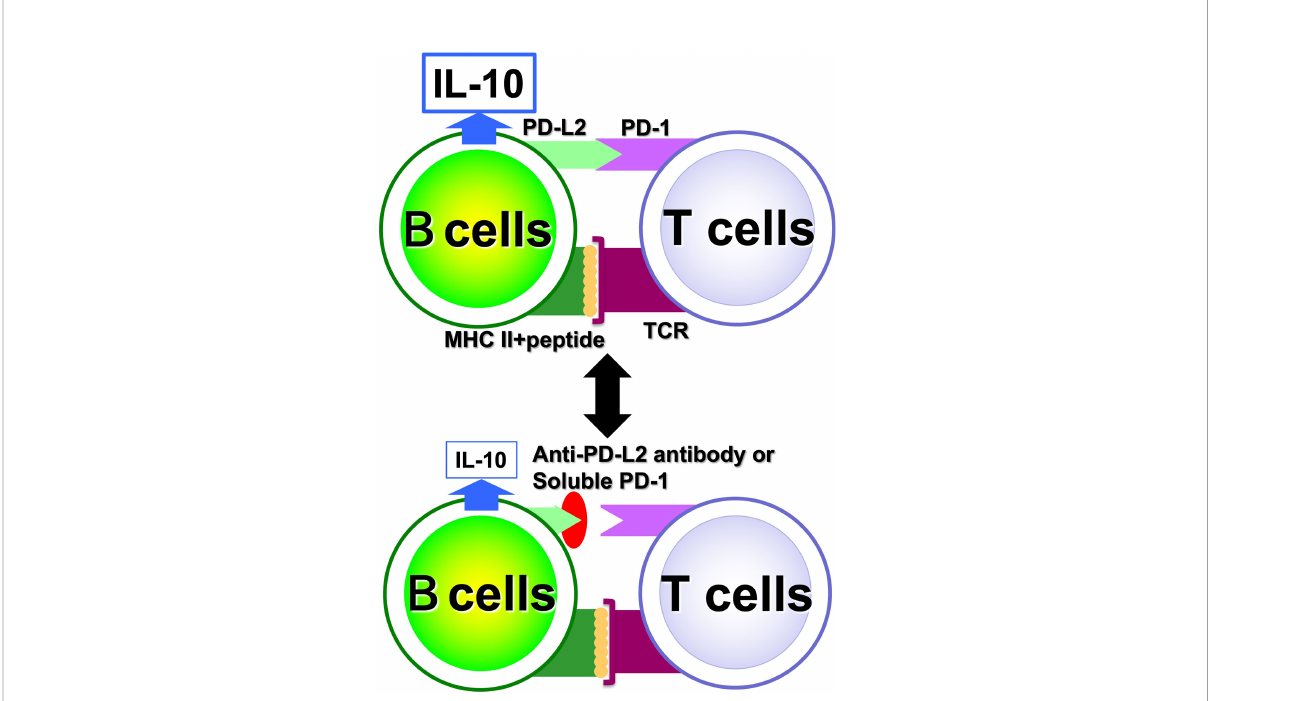
FIGURE 8 Regulation of antigen-speci fi c responses of B cells by PD-1. In antigen-speci fi c interactions between B cells and T cells, PD-1 and PD-L2 binding is involved in B cell IL-10 production; when PD-1 and PD-L2 binding is inhibited, IL-10 released from B cells is